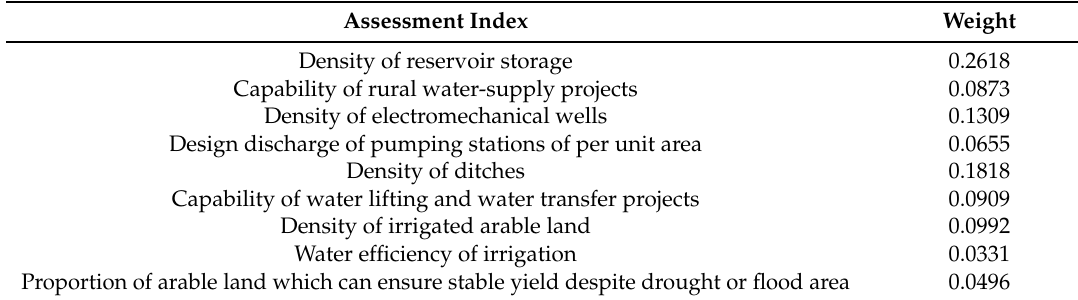
Table 6. Weight of each assessment index.